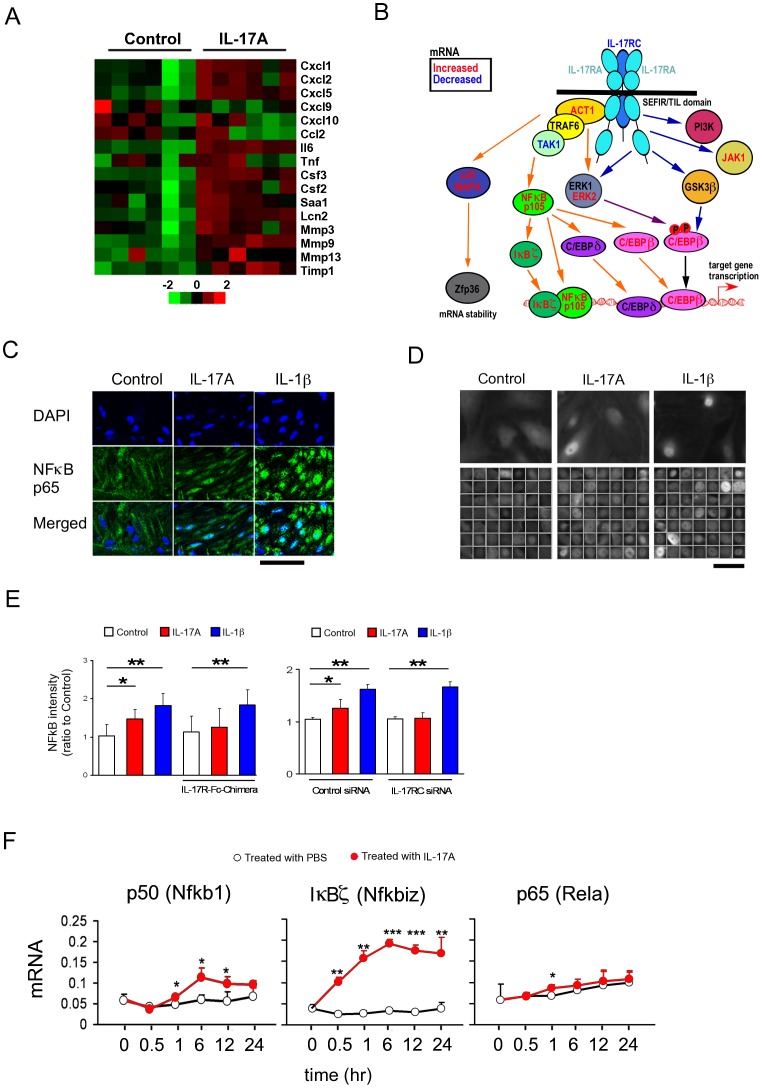
A possible involvement of the IκBζ pathway in IL-17A-induced hypercontractility.(A) Heatmap of genes expressed in MS after 24 h IL-17A treatment, assessed by microarray (n = 6). (B) Summary of changes of mRNA levels of the genes of IL-17A signalling cascade assessed by microarray (n = 6). Genes with significant changes in expression are coloured in red (increased) or blue (decreased). (C) Immunohistochemical staining for NFκB p65 protein in MS treated with or without IL-17A and IL-1β for 1 hr. Scale bars, 50 µm. (D) Immunofluorescence staining of NFκB p65 protein in primary cultured murine SMCs after 30 min treatment with IL-17A or IL-1β. Lower panels represent p65 immunosignal in the nuclei picked up automatically by the cell imaging system Celaview. Scale bar, 25 µm. (E) Relative intensity of NFκB p65 immunosignal accumulated in the nucleus treated with IL-17R-Fc-Chimera or IL17RC siRNA (n = 3∼6). (F) Time-dependent changes in mRNAs of NFκB proteins evaluated by real-time RT-PCR in mouse cultured SMCs (n = 6). Numerical data represent means ± s.e.m. *P<0.05, **P<0.01, ***p<0.001, Student's t-test (E, F) under the closed testing procedure for multiple comparison (E).